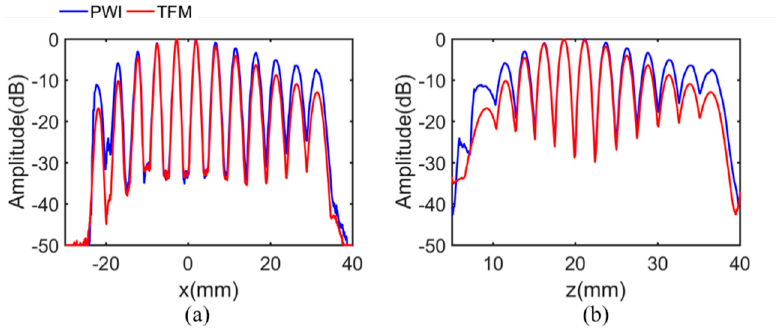
Figure 6. The projection of the maximum amplitude along the ( a ) x direction. The ( b ) z direction in simulation.